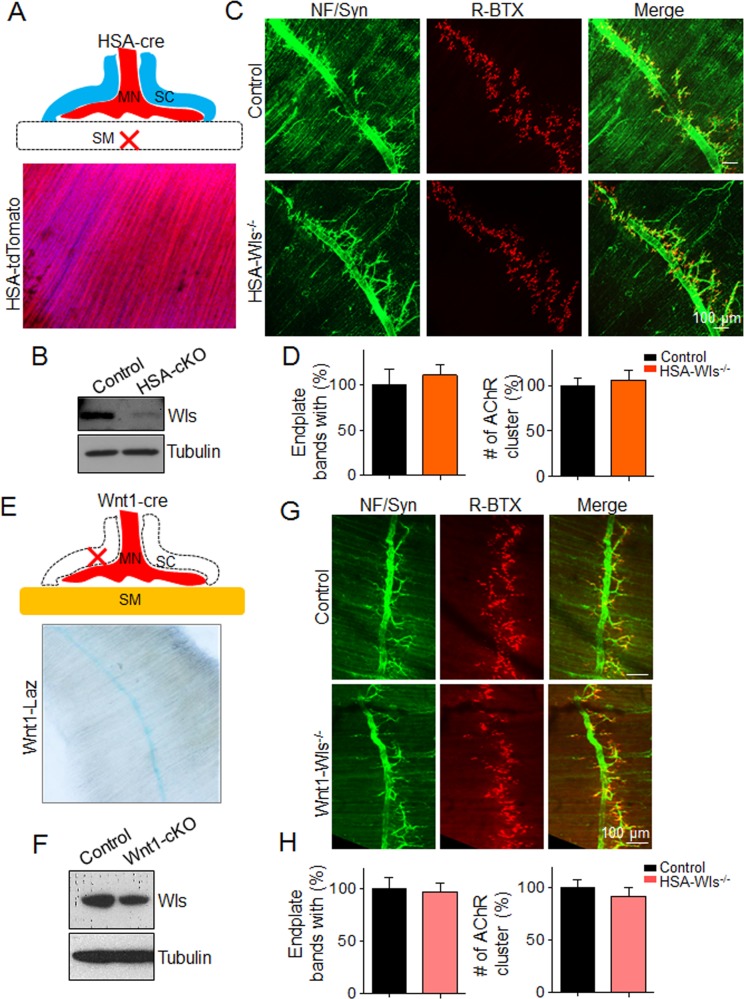
Ablation of Wls in skeletal muscle or Schwann cell has no apparent NMJ morphological defects.(A) Up: NMJ structure. Cre targets skeletal muscle (HSA::cre). Down: Cre expression was verified by crossing HSA::cre mice with Rosa-tdTomato reporter mice (HSA-tdTomato, (P7). HSA::cre drives tdTomato protein expression in each muscle fiber of diaphragm. (B) Immunoblot of Wls protein in gastrocnemius of P5 control and HSA-Wls-/- mice. (C) Immunostaining of NMJs in diaphragms of P5 control and HSA-Wls-/- mice with anti-NF and anti-Syn (Green). R-BTX stains postsynaptic AChR (Red). Control: Cre or Wlsf/f littermates. (D) Statistical results of endplate width (Left), AChR number (Right) in B. n = 5 mice per group; Unpaired t-test. p>0.05. (E) Up: NMJ structure. Cre targets Schwann cells (Wnt1::cre). Down: Cre expression was verified by crossing Wnt1::cre mice with Rosa-Laz reporter mice (Wnt1-Laz, (P7). Wnt1::cre drives laz expression in middle line of diaphragm where Schwann cells surround the innervated motor axons (Wnt1-Laz). (F) Immunoblot of Wls protein in sciatic nerve of E18.5 control and Wnt1-Wls-/- mice. (G) Immunostaining of NMJs in diaphragms of E18.5 control and Wnt1-Wls-/-with anti-NF and anti-Syn (Green), R-BTX (Red). Control: Cre or Wlsf/f littermates. (H) The statistics of endplate width (Left), AChR number (Right) in E. n = 5 mice per group; Unpaired t-test. p>0.05.